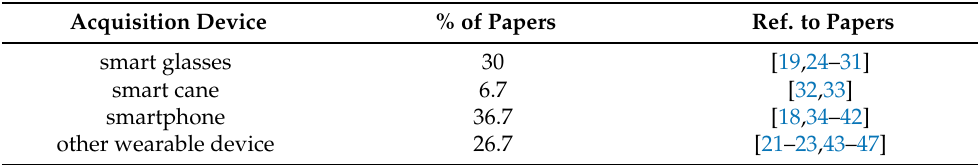
Table 1. The type of acquisition devices used in each paper. Acquisition